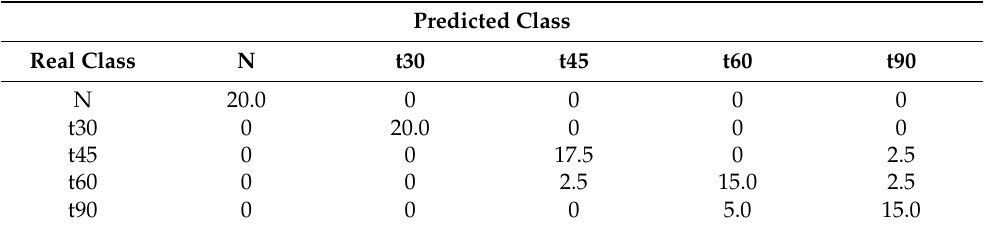
Table 3. Confusion matrix obtained through PLS-DA for discrimination between almond seeds subjected to different thermal treatments before oil extraction. Values are expressed in percentage.